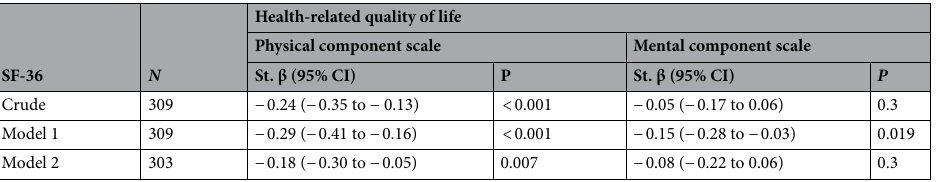
Table 3. Analyses with hand dexterity as potential determinant of health-related quality of life. Model 1: adjusted for sex and age. Model 2: model 1 additionally adjusted for educational level, body mass index, diabetes, dialysis before transplantation, time since transplantation, hemoglobin, C-reactive protein and plasma albumin. Results are presented in standardized beta (st. β) coefficients with 95% confidence intervals (95%CI). Abbreviations: SF-36, Short Form-36; st. β, standardized beta; CI, confidence